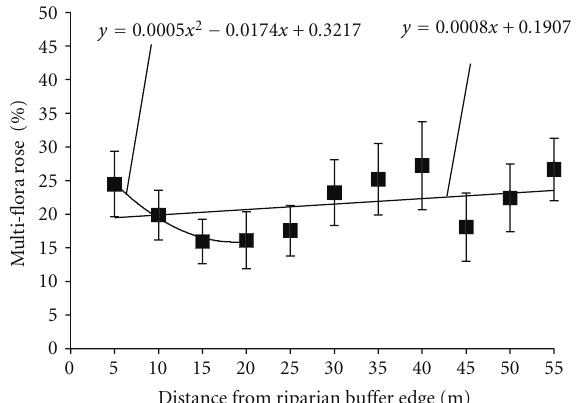
Figure 4: The prevalence of multiflora rose away from the edge of forested riparian bu ff ers in Delaware and Pennsylvania, 2007- 2008. Within-subject contrasts indicated a significant ( P < 0 . 10) decreasing quadratic trend through 20 m but a linear increasing trend through 55m.